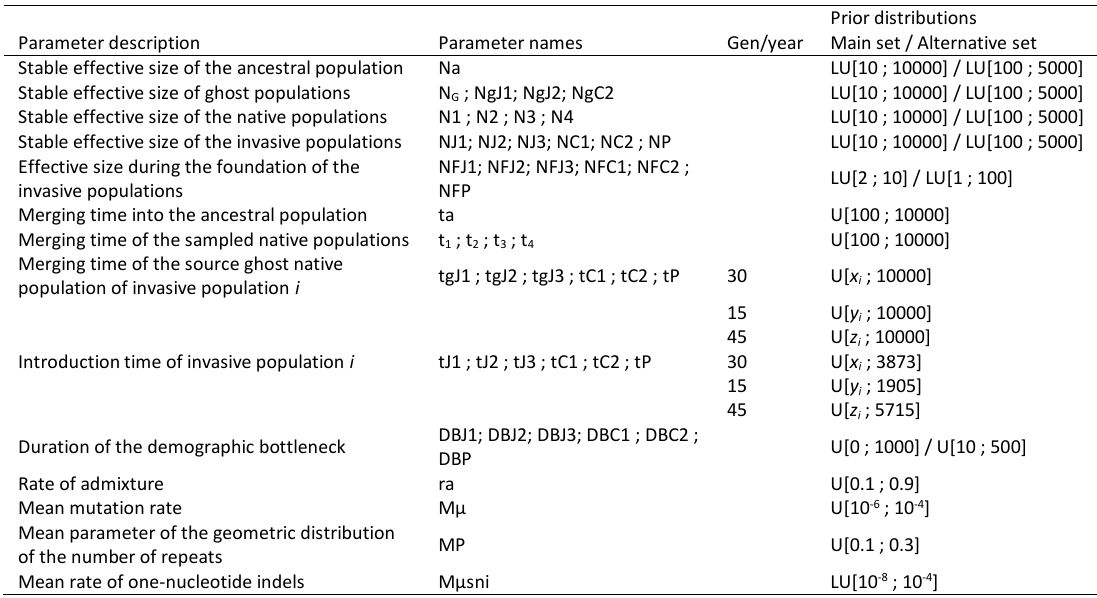
Table 2: Definition and prior distributions of parameters used in the scenarios of invasion considered in the ABC